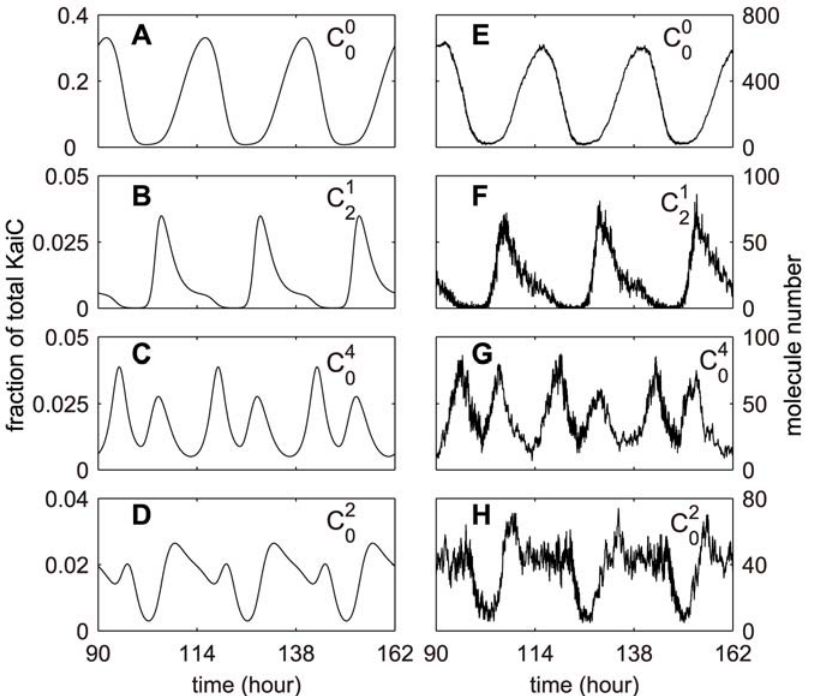
Figure 5. Stereotypes of diverse waveforms exhibited in KaiC phosphoforms from both deterministic and stochastic simulations. Stereotypes of four groups of waveforms of KaiC are selected: C 0 0 for group 1 (A and E); C 1 2 for group 2 (B and F); C 4 0 for group 3 (C and G) and C 2 0 for group 4 (D and H). (A–D) for deterministic model, while (E–H) for stochastic model. The total number of KaiC hexamer is 2000 in stochastic simulation (see section 2.3 in Text S1).